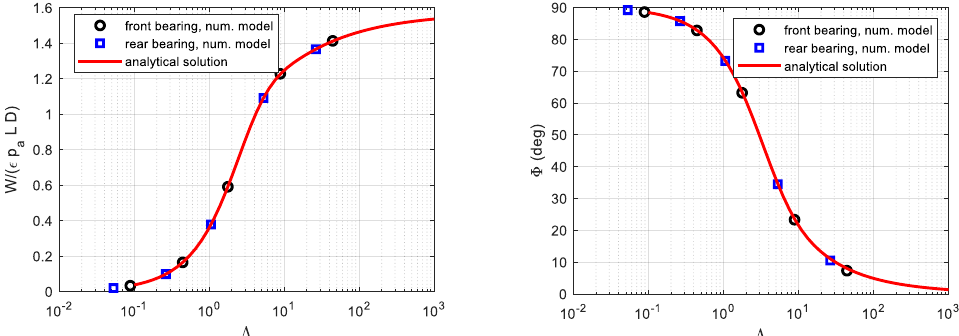
Figure 7. Dimensionless load capacity and attitude angle of plane dynamic journal bearings; com- parison between the analytical formulation and numerical results.